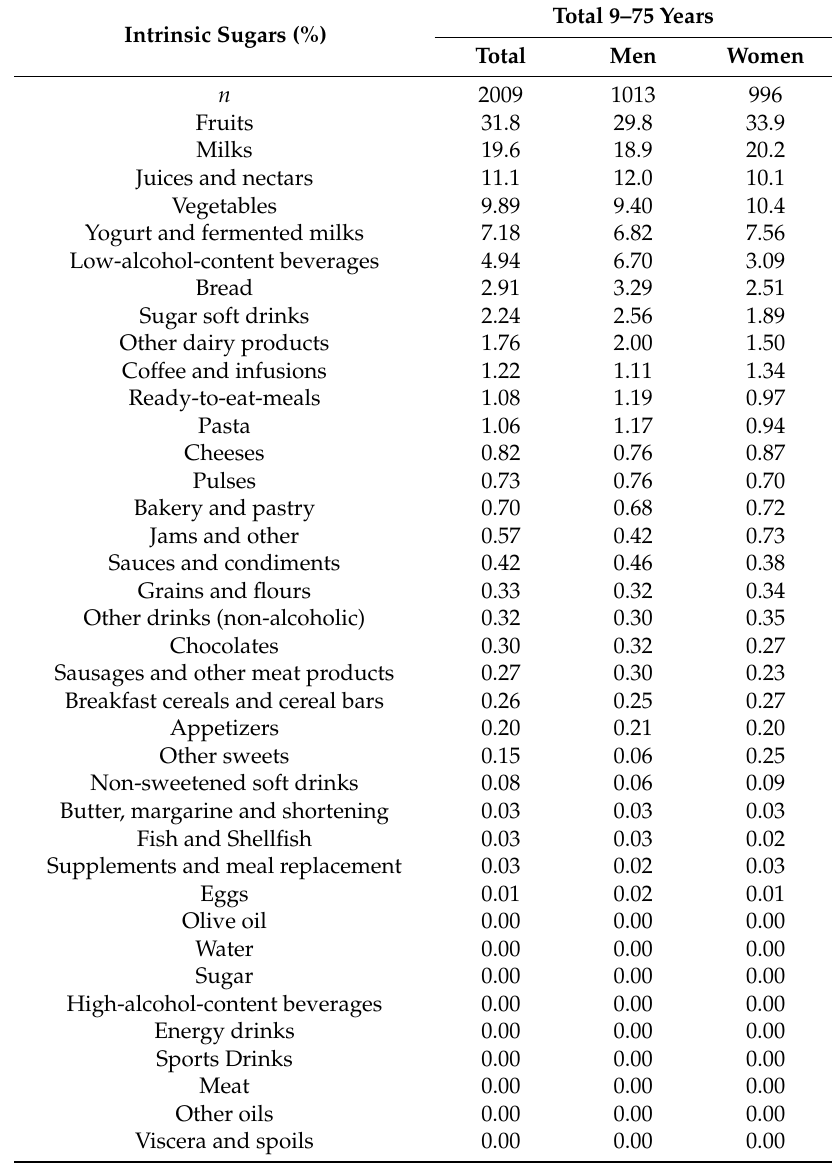
Table 5. Dietary sources of intrinsic sugars (%) from food and beverage subgroups in the ANIBES Study Spanish population aged 9 to 75